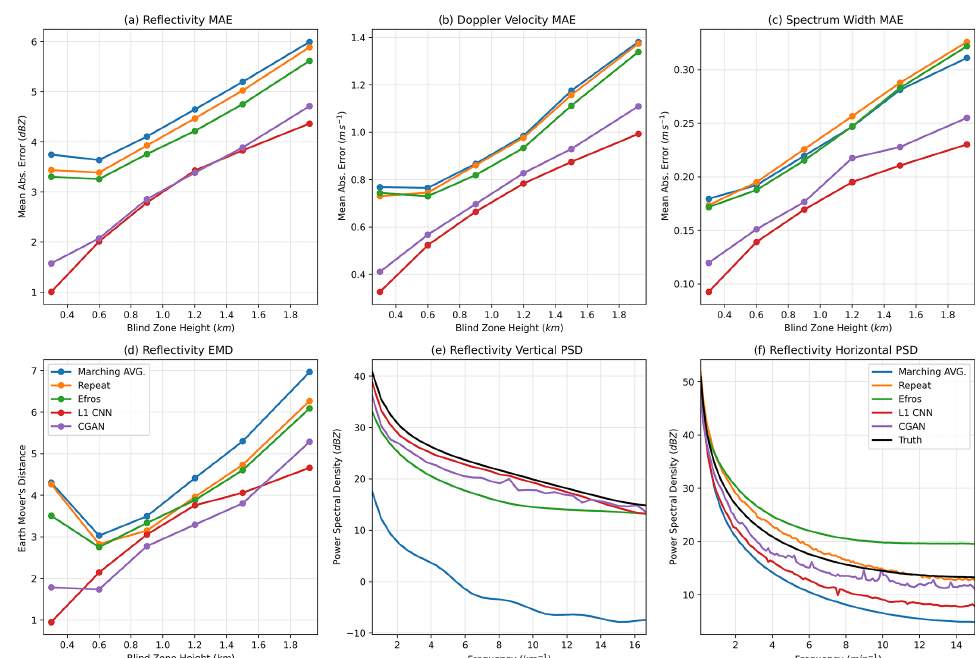
Figure 6. Error metrics computed on the KaZR low-level blind zone. Panels (a) – (c) show mean absolute pixel errors. Panel (d) shows the earth mover’s distance. Panels (e) and (f) show power spectral